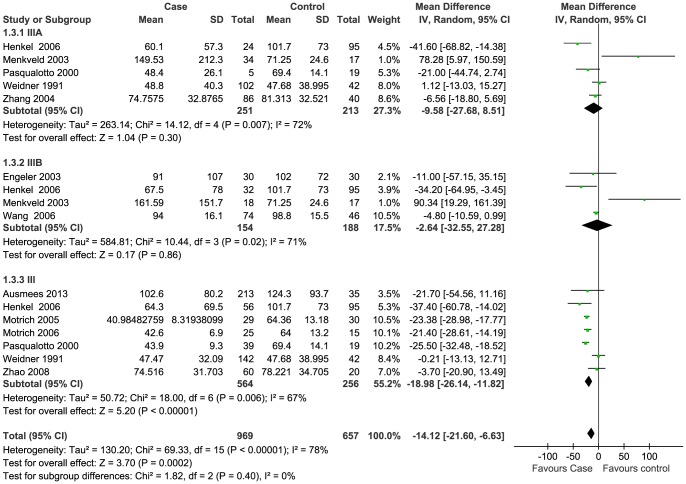
Forest plot showing the meta-analysis outcomes of the effect of CP/CPPS on sperm concentration.